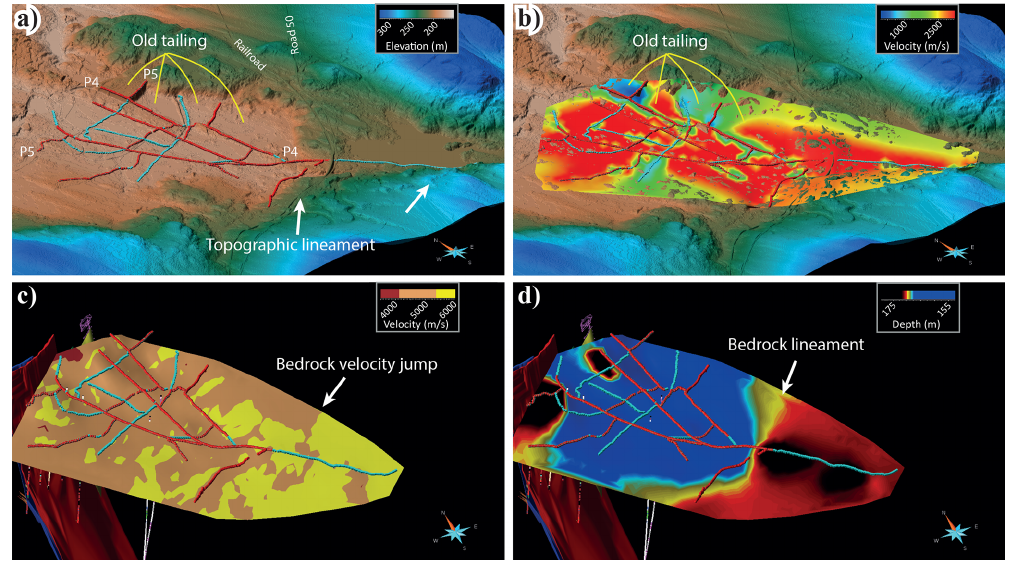
Figure 9. (a) Lidar elevation map of a portion of the 3D survey area showing built-up roads and a historical tailing where P4 and P5 were positioned. (b) Near-surface velocities derived from the 3D refraction static solution showing the clear position of the tailing as low-velocity materials and the two separate ponds immediately south of it. (c) Bedrock velocities and a sharp jump in the velocity south of the survey area and (d) bedrock level from the 3D refraction static solution showing a clear lineament (higher ground) immediately south of the road 50 (and the railroad). We attribute the bedrock lineament to a single (or a set of) normal